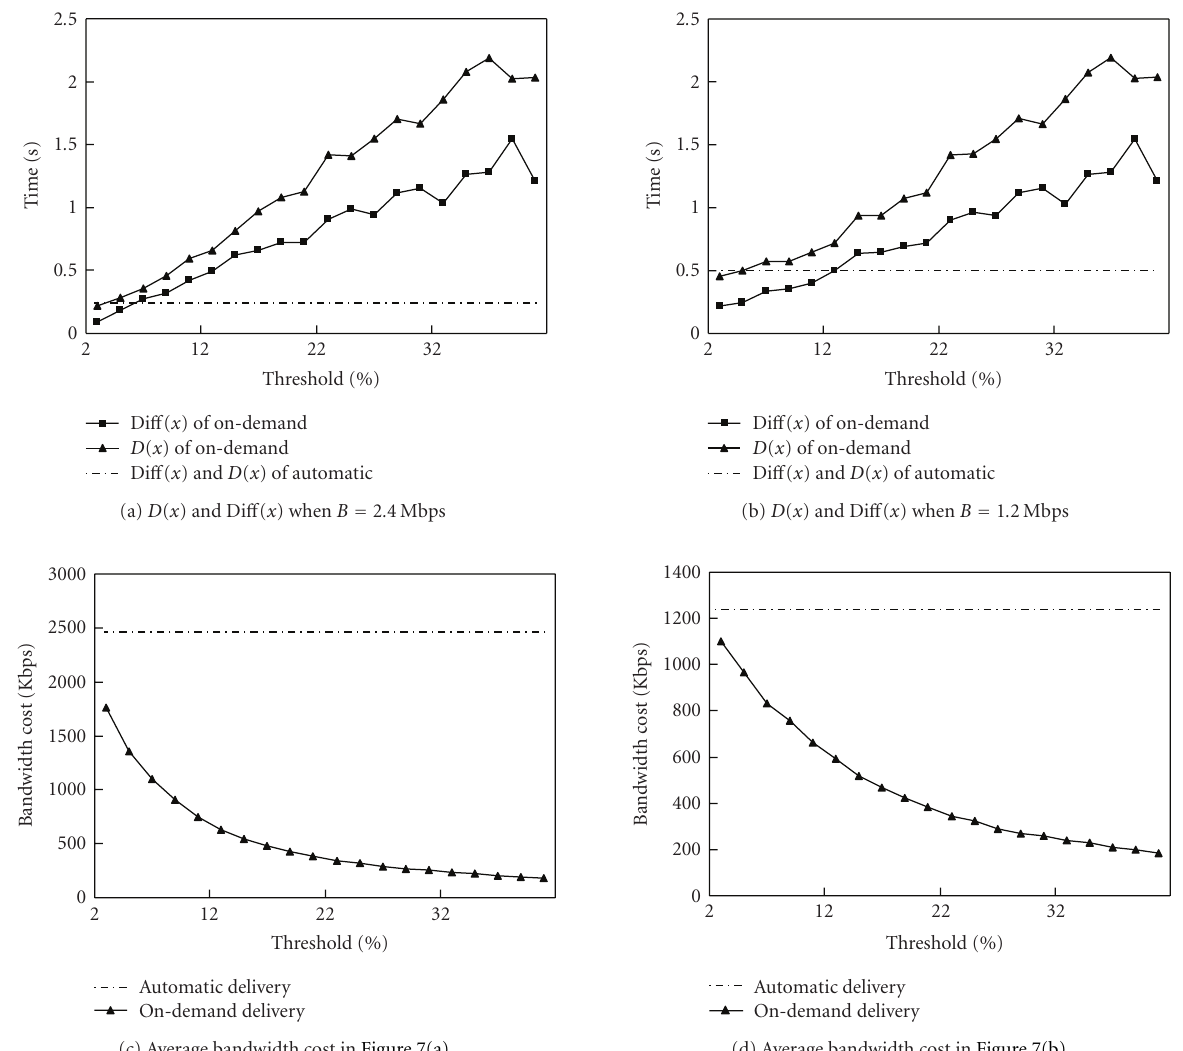
Figure 7: Average latency and di ff erence of a Kongfu